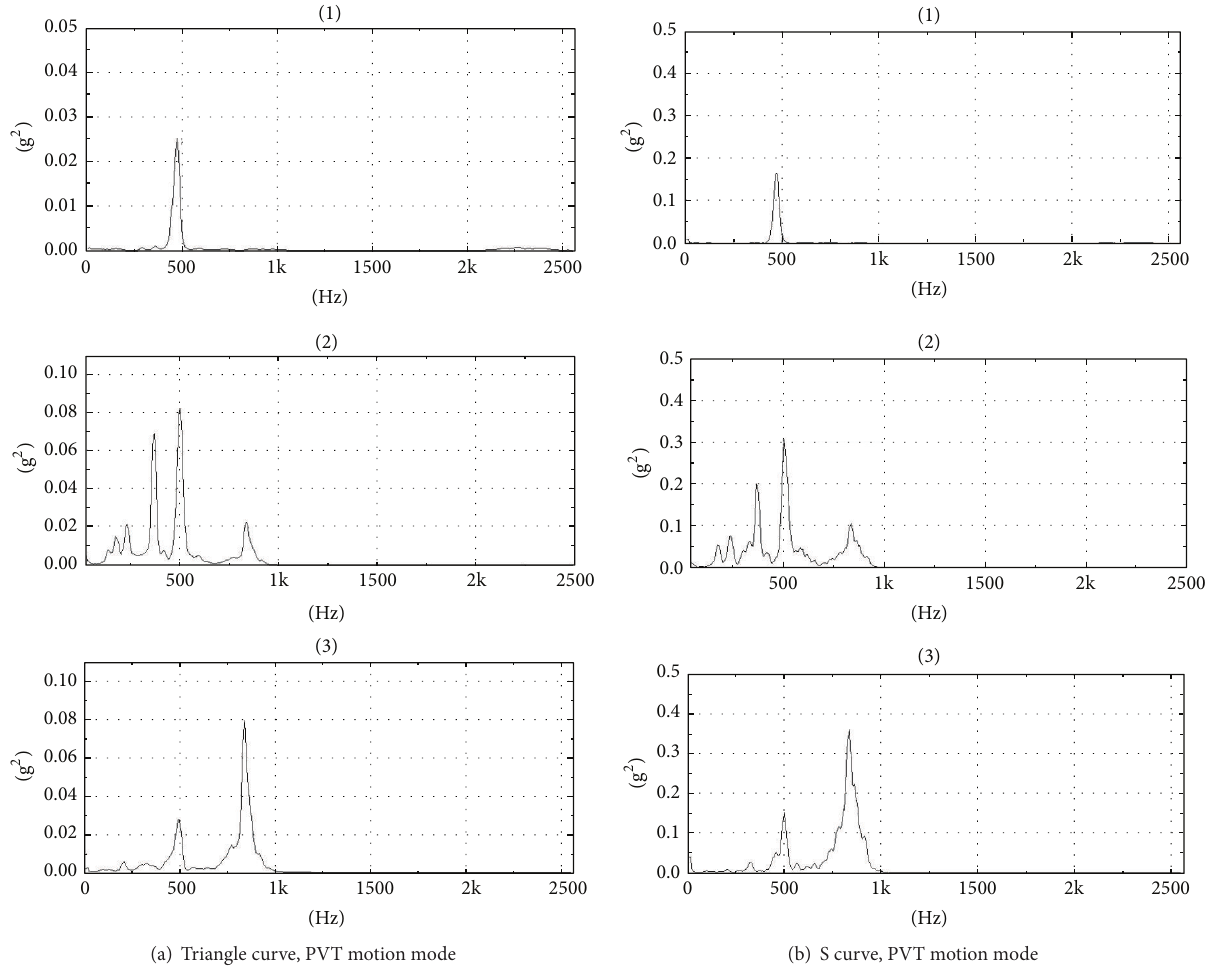
Figure 10: Power spectrum of linear-motor-driven water piston pump system under triangle and S motion